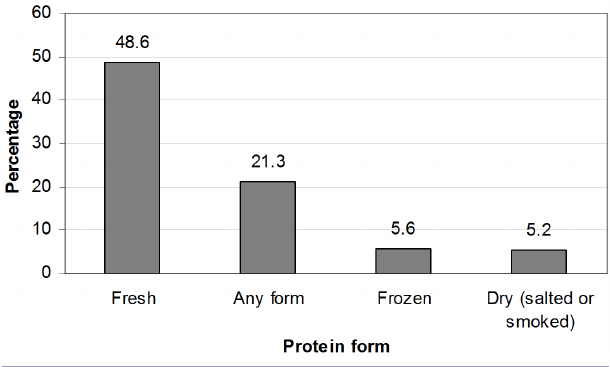
Fig. 4 . Preference according to the form of animal protein by